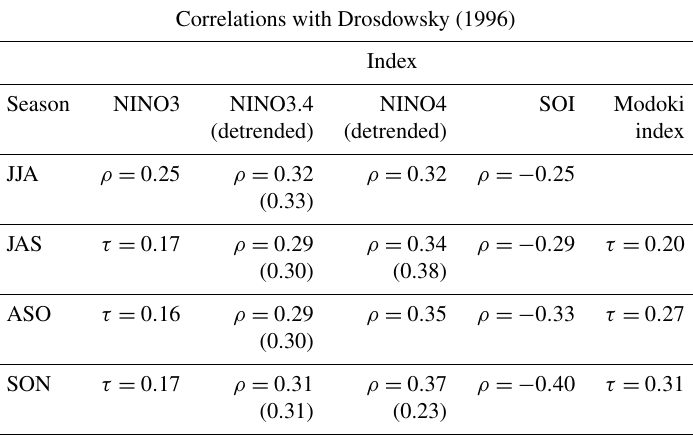
Table 3. Correlation coefficients of seasonal ENSO indices with Drosdowsky (1996) monsoon onset dates. Only statistically significant ( p< 0 . 05) values are